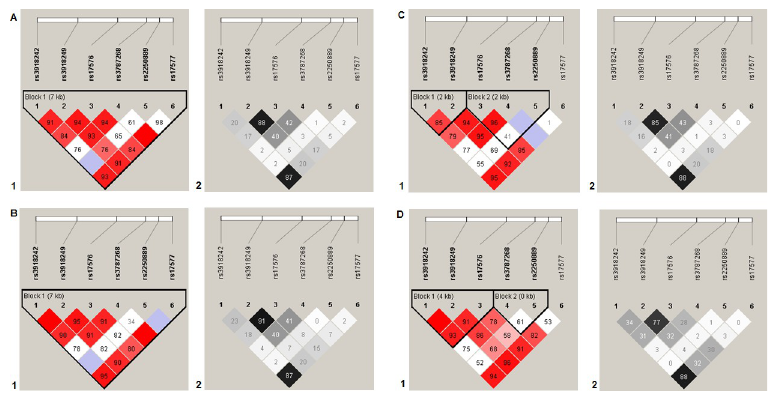
Fig 1. Linkage disequilibrium (LD) between SNPs rs3918242, rs3918249, rs17576, rs3787268, rs2250889 and rs17577 of the MMP9 gene in GU patients. A, summary; B, H . pylori -positive GU patients; C, H . pylori -negative GU patients; D, control group. LD values are given as Lewontin’s standardized coefficient D 0 (Figure sections 1) and the square of the Pearson’s correlation coefficient (r 2 ) (Figure sections 2) between SNPs.